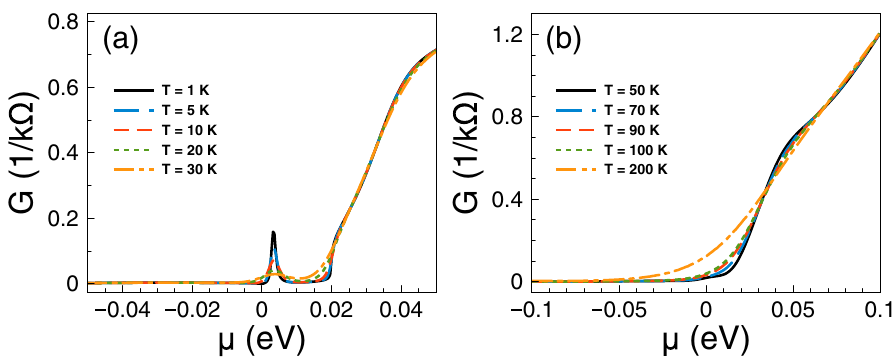
Figure 9. Conductance function versus chemical potential for gapless bilayer graphene double barriers at different temperatures: ( a ) from 1 K to 30 K and ( b ) from 50 to 200 K. The double barriers structural parameters are d B = d W = 6 nm and V 0 = 50 meV. As we are dealing with symmetric barriers d B 1 = d B 2 = d B . At low temperatures it is possible to see the contribution of Breit–Wigner resonances directly on the conductance as a peak as well as how this peak evolves as the temperature rises.